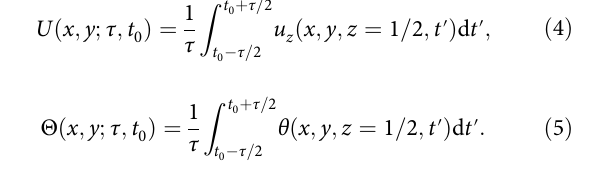
Fig. 2 Magnitude of turbulent superstructures. The panels compare the root mean square (rms) values of the full fi eld, T 2 (cid:1) (cid:3) (cid:1) (cid:3) 1 = 2 1 = 2 fi ned in Eqs. (4, 5), and the fl uctuations about the temporal mean, T ′ 2 means Θ 2 ~ V and U 2 ~ V as de for the vertical velocity component u z in c , d . The dependence on Pr at Ra = 10 5 is given in a , c and on Ra at Pr = 0.7 in b , d . The data for the temporal means are shown in Fig.